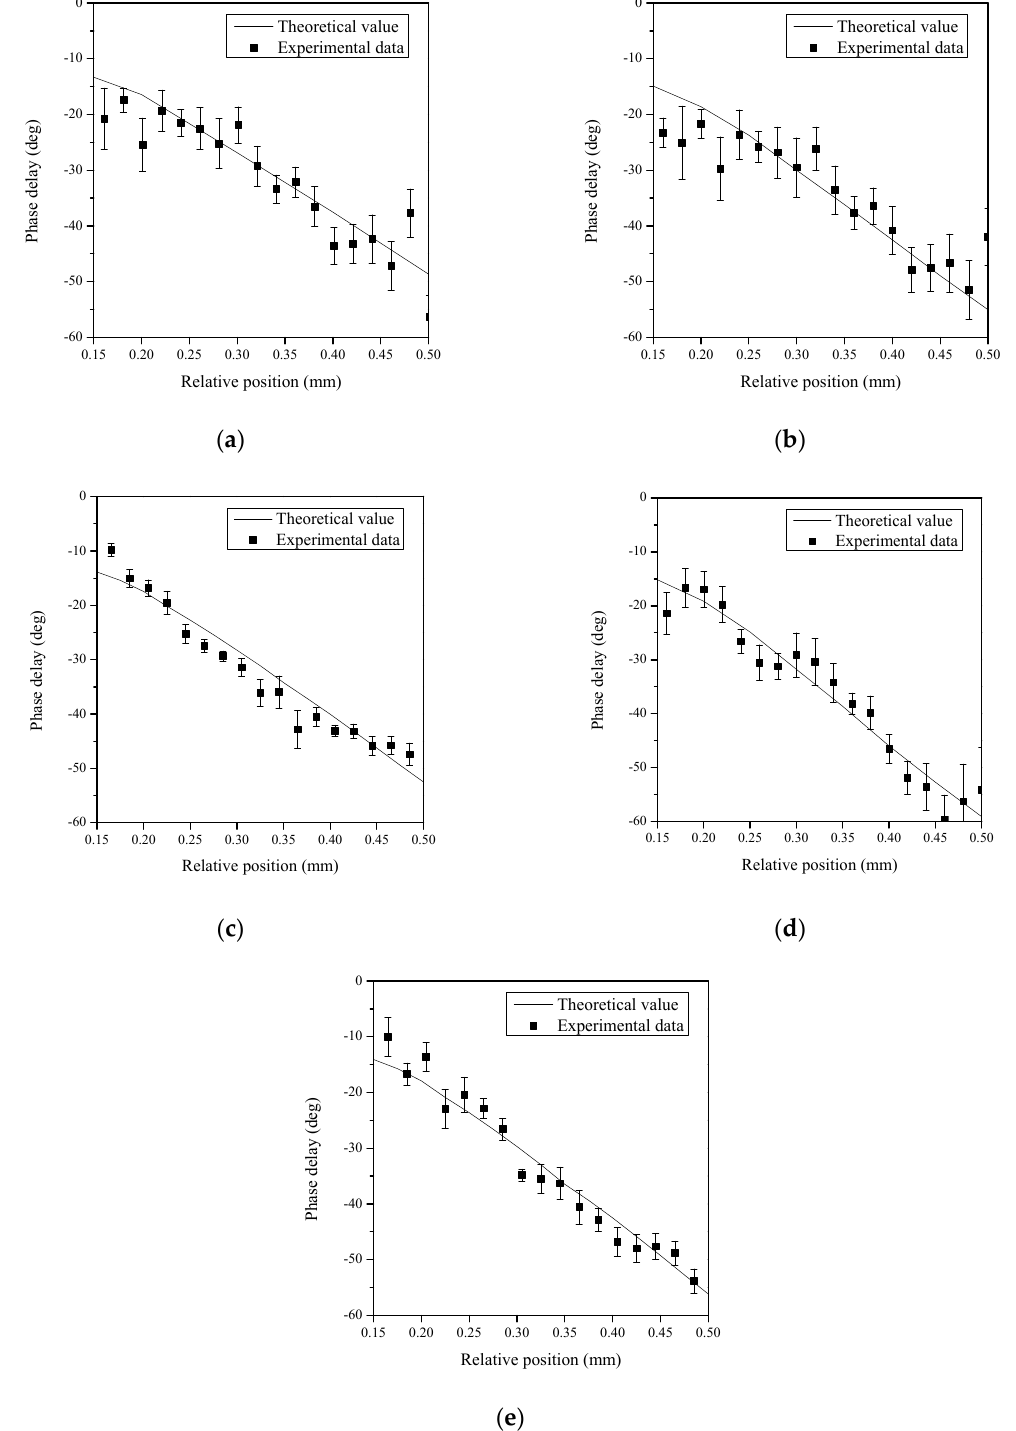
Figure 9. Comparison of experimental and theoretical results for various measurement directions. ( a ) θ = 0 ◦ . ( b ) θ = 30 ◦ . ( c ) θ = 45 ◦ . ( d ) θ = 60 ◦ . ( e ) θ = 90 ◦ .